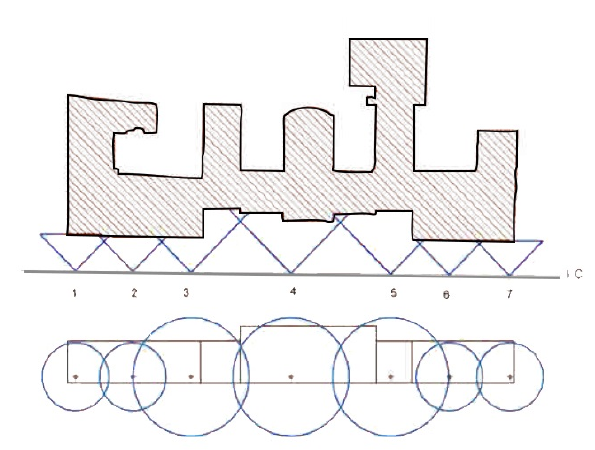
Figure 14. Representation of the laser scanner projections in Customized Condition – graphic elaboration by Maria Chiara